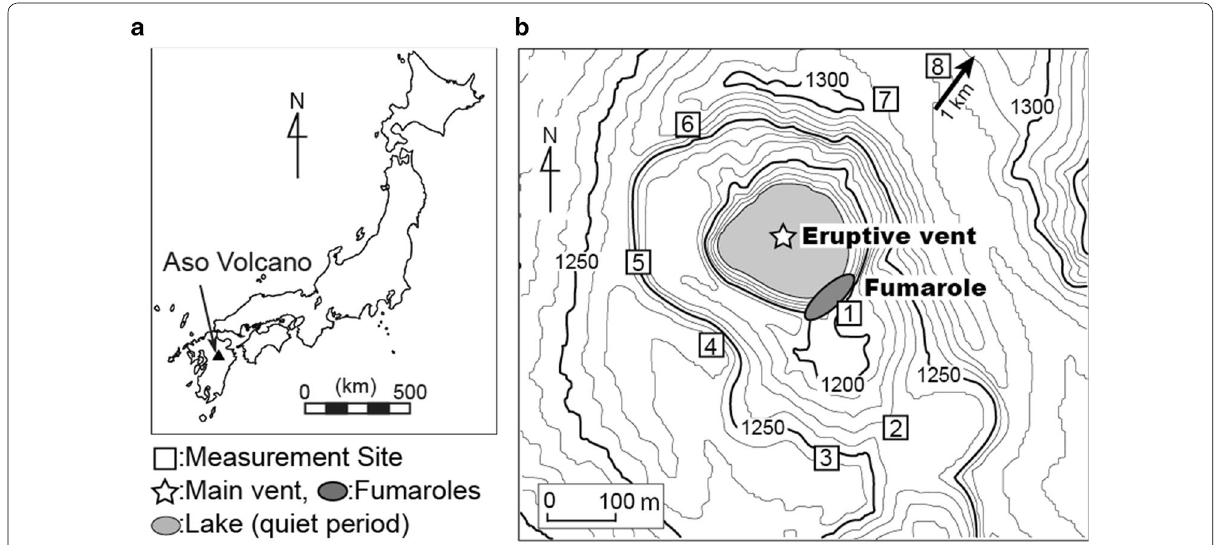
Fig. 1 Location maps. a The location of Aso volcano in Japan; b distribution of the Yudamari crater lake and the fumarolic area at the southern wall of the summit crater of Nakadake central cone, Aso volcano. Contours are in 10-m intervals. The numbers in squares indicate the locations of plume measurement (Table 1). The location 8 is located further 1 km to the northeast from the point on the